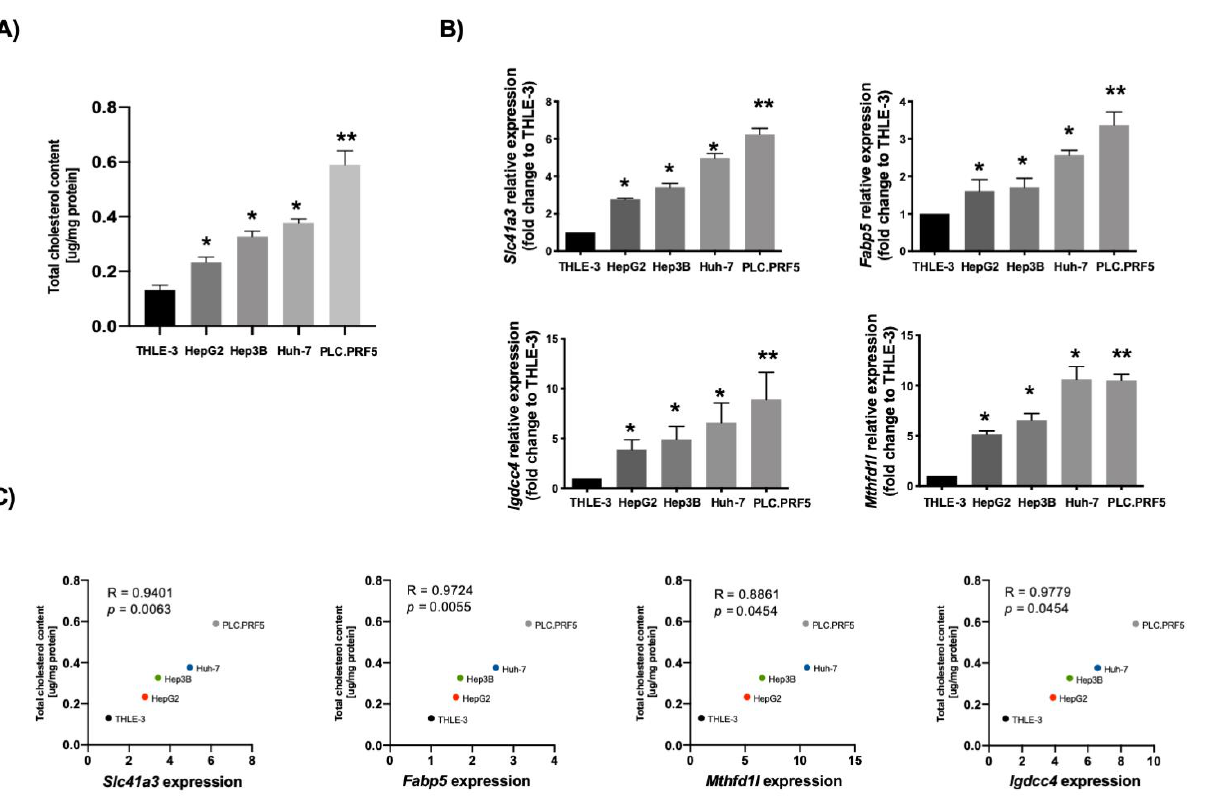
Figure 6. Lipid-associated four-gene signature of hepatocellular carcinoma (HCC) correlates with cholesterol overload in human cancer cell lines. ( A ) Total cholesterol quantification in different human HCC-derived cell lines ( n = 4). ( B ) Slc41a3, Fabp5, Igdcc4 and Mthfd1l gene expression addressed by qRT–PCR in different HCC-derived human cell lines. THLE-3 cells were used as control ( n = 4). Each bar represents the average ± SEM * p < 0.05; ** p < 0.01 vs. THLE-3 cells. ( C ) Pearson’s correlation analysis between total cholesterol content and gene expression of Slc41a3, Fabp5, Igdcc4 and Mthfd1l ( n =